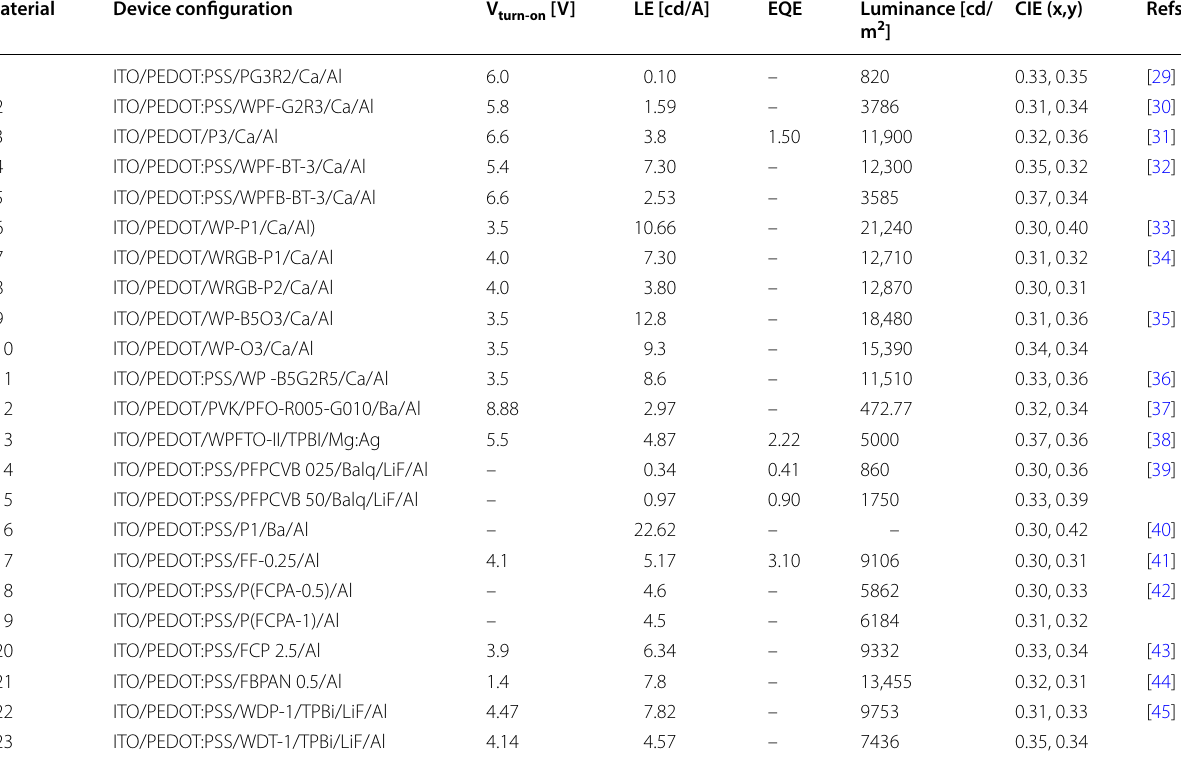
Table 1 EL performance of the single layer copolymers Material Device